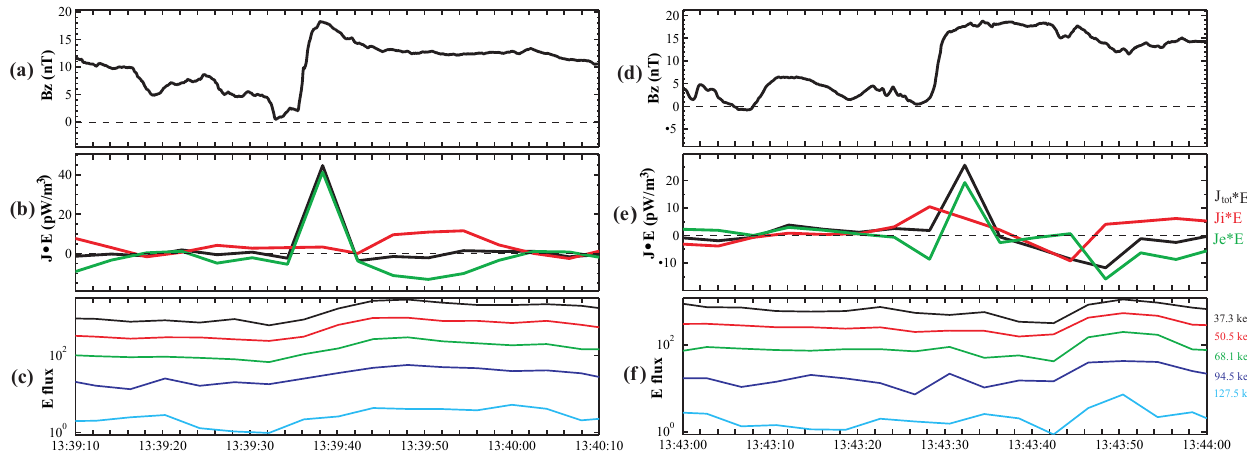
Fig. 4. Magnetic filed B z , J · E ( J tot · E , J i · E , and J e · E ), and the differential fluxes of energetic electrons (1/(cm 2 strskeV)) are displayed from top to bottom